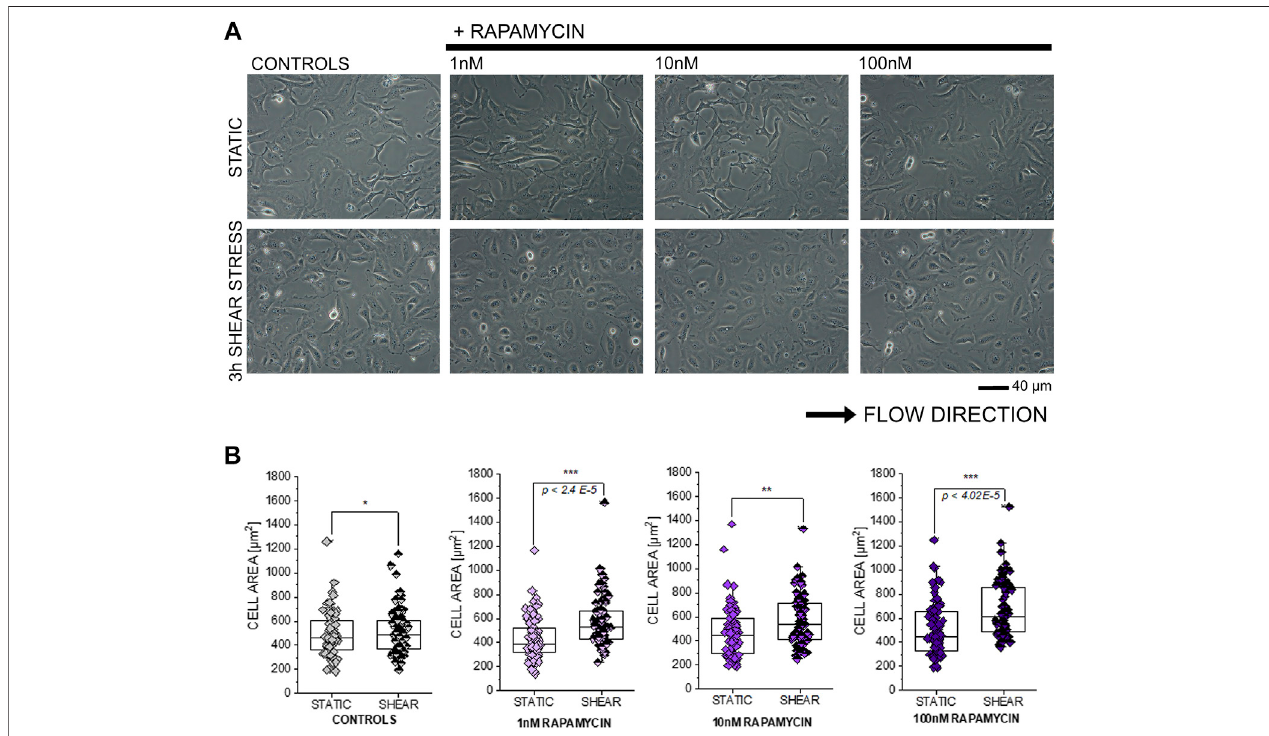
FIGURE 7 | Response of T24 to shear stress stimulation. (A) Bright fi eld appearance of T24 cells after incubation with rapamycin (1 – 100 nM). (B) Quanti fi cation of cell area in static conditions and after biomechanical stimulation. Morphometric data are mean of n (cid:1) 70 cells randomly quanti fi ed from three to four independent cell preparations. * indicates signi fi cant difference in comparison to controls at the Student ’ s t -test (*: p ≤ 0.05; **: p ≤ 0.01 ***: p ≤ 0.001; scale bar: 40 µm).